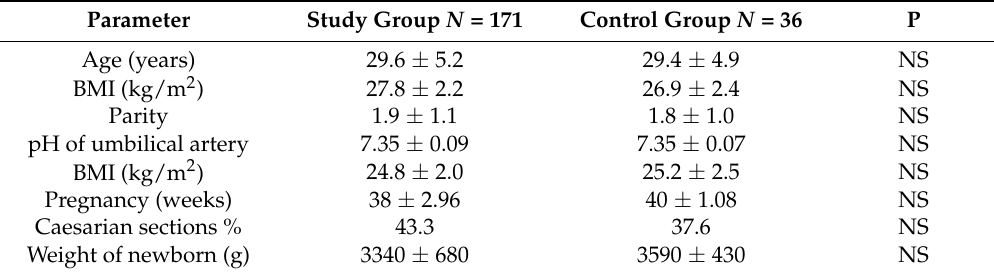
Table 5. Baseline characteristics of the study participants. NS: not significant; BMI: body mass index; P: p